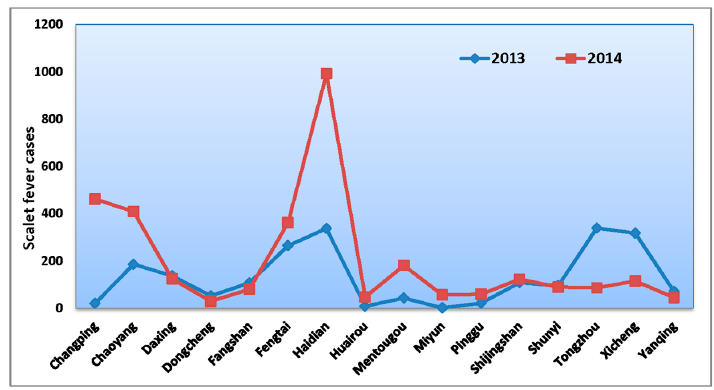
Figure 2. Distribution of scarlet fever cases in Beijing districts, 2013–2014.